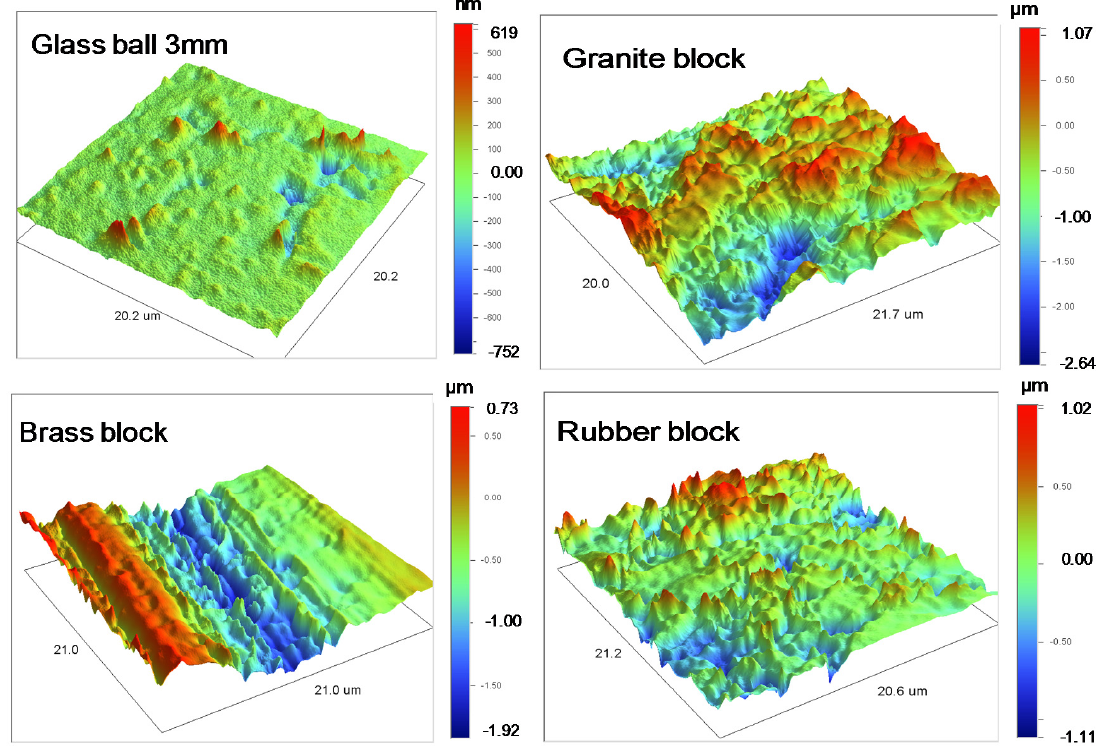
Figure 2. Typical flattened three-dimensional surface topographs of glass ball (3 mm) and base Table 1. Summary of material properties for the grains and blocks used in the impact tests.